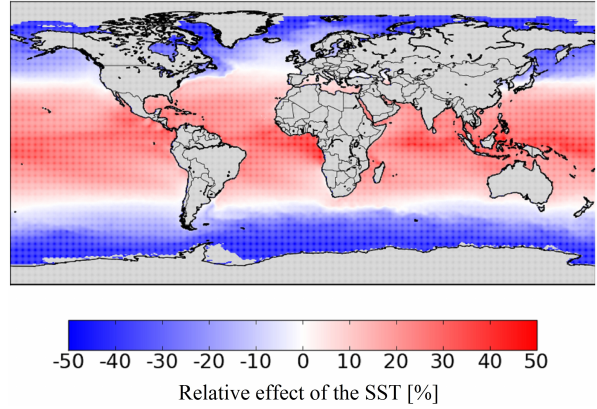
Fig. 10. The relative SST effect on the number flux of particles smaller than 1µm: colour scale represents the relative difference between the flux calculated using standard OSSA-SSSF and OSSA- SSSF with constant viscosity (SST=15 ◦ C, salinity